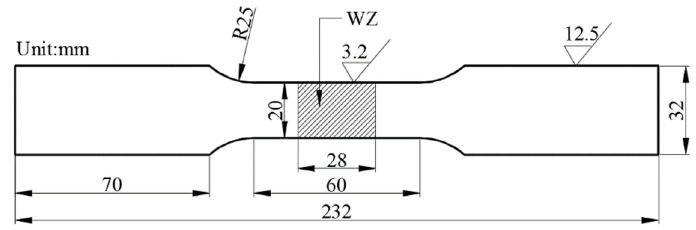
Figure 5. Cross-sectional dimension of tensile specimen .